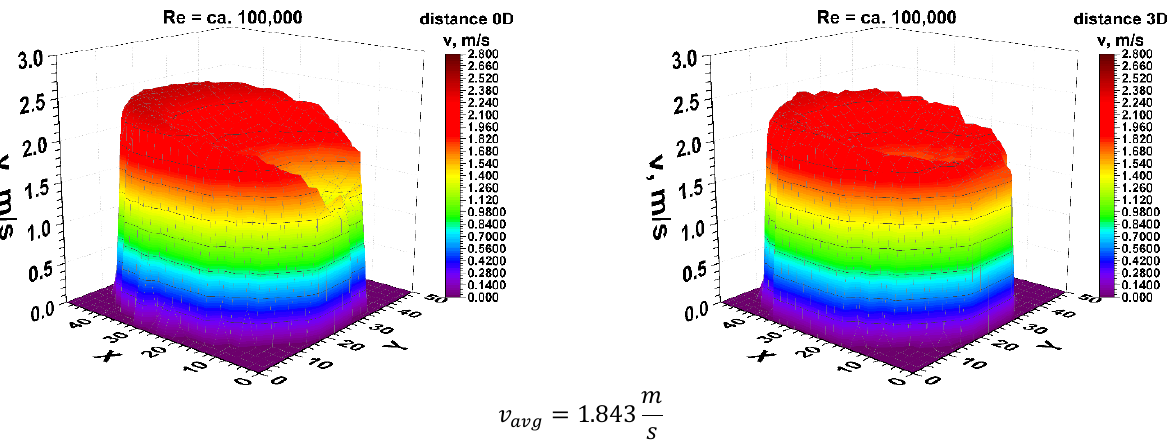
Figure 6. Comparison of velocity blocks at the distance 0D and 3D from the disturbance obtained by means of LDA measurements for Re ≅ 100,000.